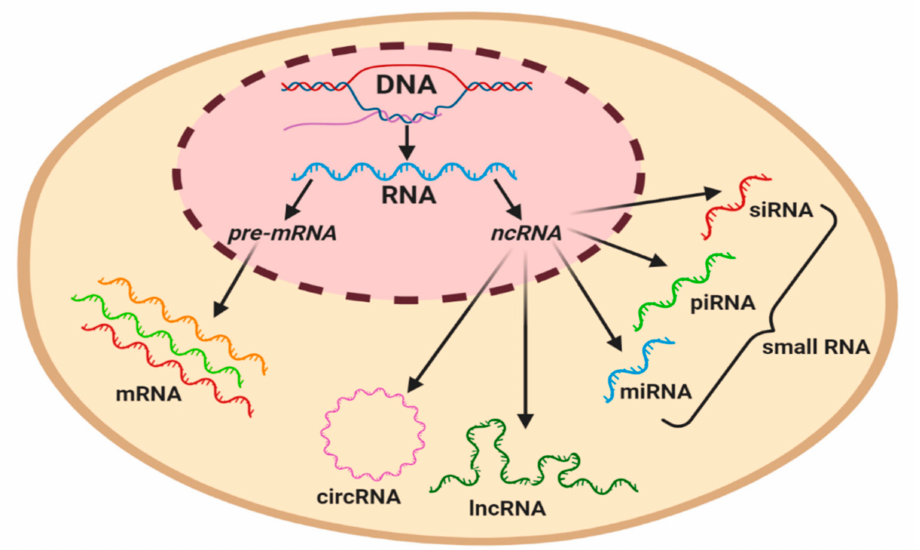
Figure 2. Graphical classification of coding and regulatory non-coding RNAs in a eukaryotic cell. Precursor mRNA (pre-mRNA) gives rise to mRNA. ncRNAs can be subcategorized based on their length, with the longest circulating RNA (circRNA) and long non-coding RNAs (lncRNAs) being ~200 nt in length, whilst miRNA (19–23 nt), piwi-interacting RNA (piRNA) (23–32 nt), and small interference RNA (siRNA) (20–25 nt) are classified as small